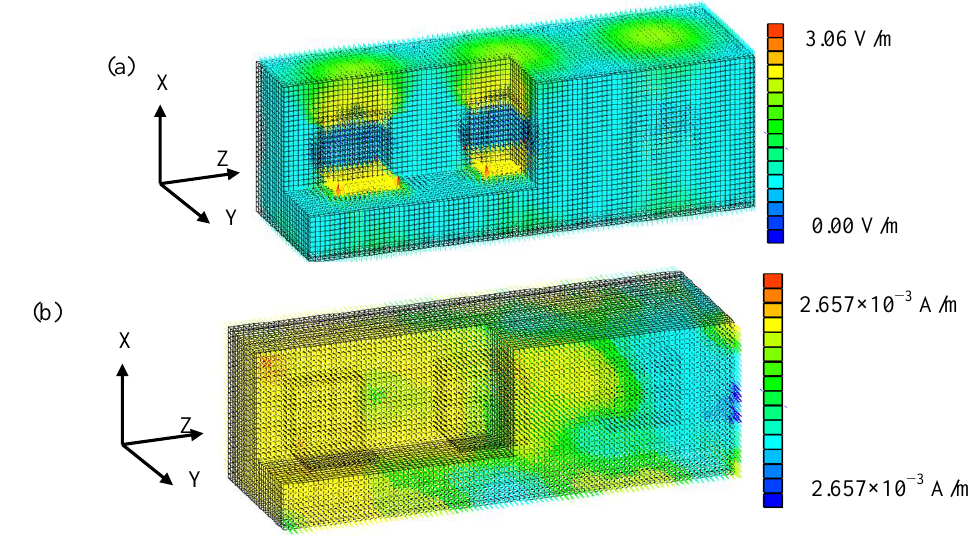
Figure 5. Electromagnetic field calculation result (water, volume rate: 10%). ( a ) Electrical field, real part. ( b ) Magnetic field, real part.